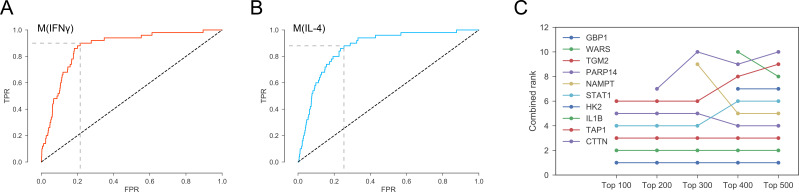
(A) Optimal threshold on the network-based prioritization ranking maximizing the sum of sensitivity and specificity. The optimal threshold value was the top 2971 candidates for M(IFNγ).(B) Optimal threshold on the network-based prioritization ranking maximizing the sum of sensitivity and specificity. The optimal threshold value was the top 3496 candidates for M(IL-4). (C) The sensitivity of the combined ranks to the filtering based on expression and abundance. ‘Top 100’ indicates proteins filtered by choosing the top 100 in gene expression and protein abundance, and so on.